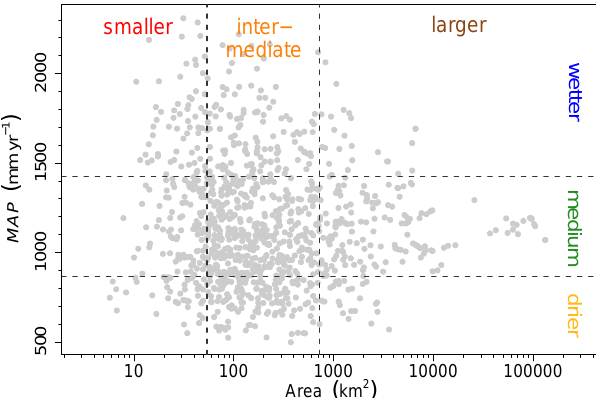
Figure 2. Catchment characteristics of the Austrian, Slovakian and Italian data sets. For each catchment, MAP is plotted against catch- ment area (grey circles). Black, dashed lines represent the 20 and 80% quantiles for each catchment descriptor, defining the subsets as smaller (area < 55km 2 ), intermediate (55km 2 < area < 730km 2 ), larger (area > 730km 2 ), drier (MAP < 860mmyr − 1 ), medium (860mmyr − 1 < MAP < 1420mmyr − 1 ), and wetter catchments (MAP > 1420mmyr − 1